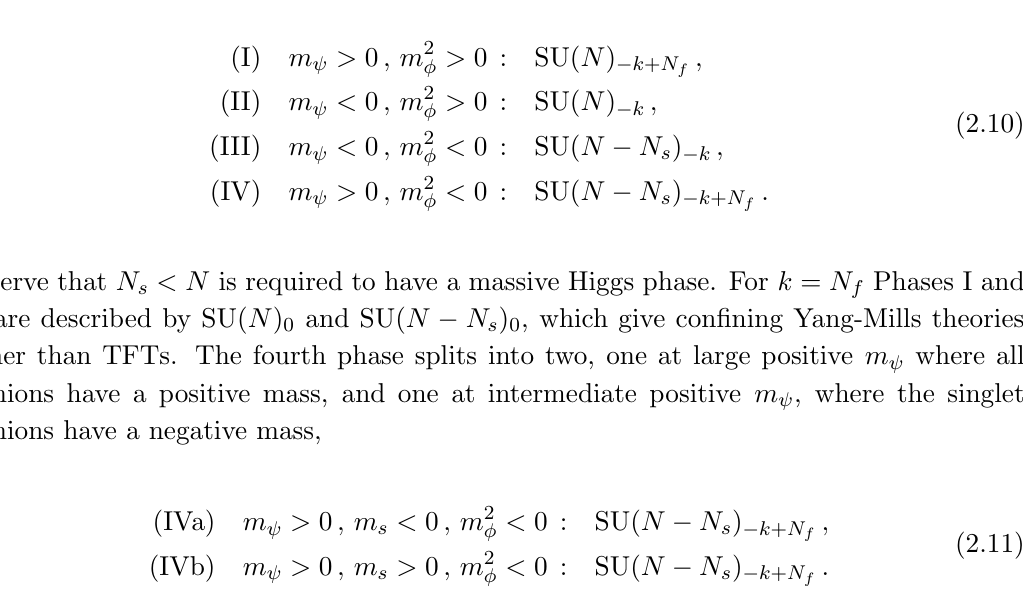
Figure 1. For N s < N , the schematic phase diagrams of (a) SU( N ) coupled to N f fermions and N s scalars and (b) U( k ) fermions and N f scalars. The various phases are described by IR TFTs given in (2.10) and (2.13). and the critical lines are described by the CFTs given in (2.12) and